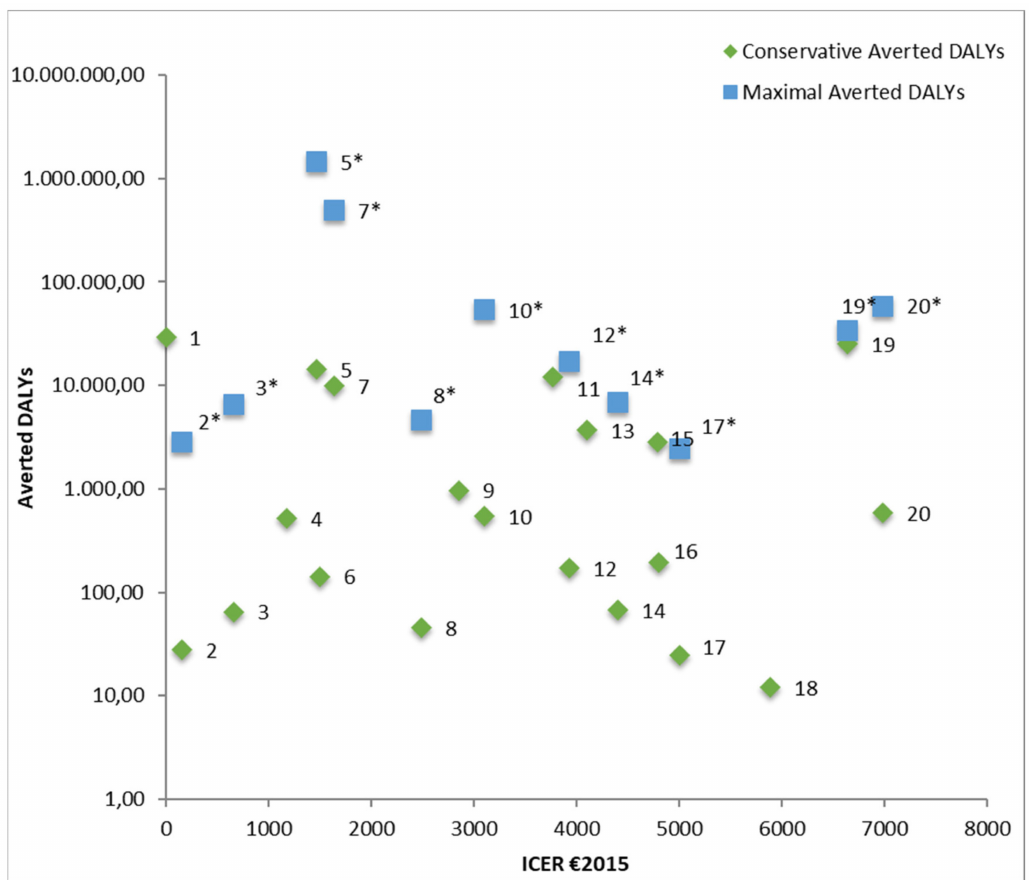
Figure 5. ICER and CAD of the top 20 interventions with log transformation for y-axis (labels correspond to intervention labels in Table 2). * Interventions marked by an asterisk (*) have di ff erent CAD and MAD, because the total number of persons in the population concerned is much higher than their conservative reach (1% of the total target population). 5* (MAD = 1,440,174), 7* (MAD = 497,365) and 10* (MAD = 54,180) have a markedly higher MAD than the others